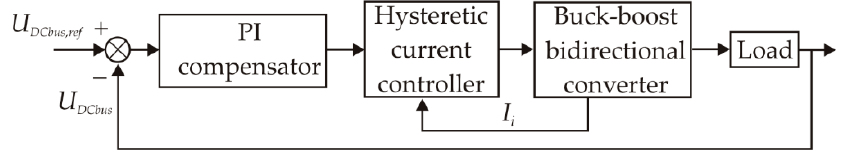
Figure 10. Global control of the battery power converter.